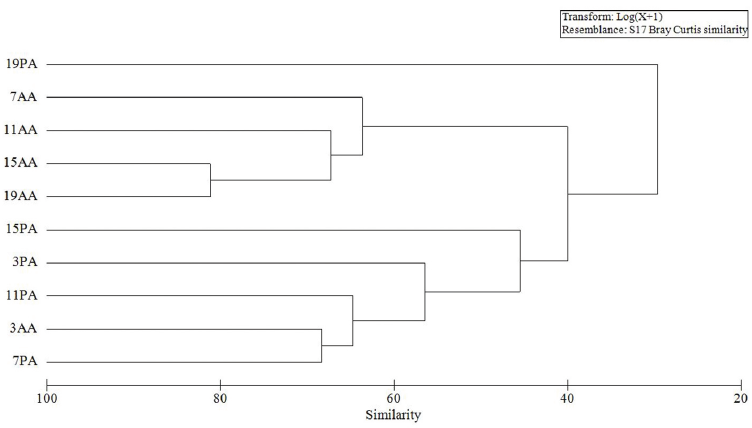
Figure 4. Dendrogram (UPGMA) based on the Bray-Curtis similarity index with the taxonomic composition of aquatic invertebrates in the presence (PA) and absence (AA) of A. longirostri , after 3, 7, 11, 15 and 19 days of leaf exposure to the